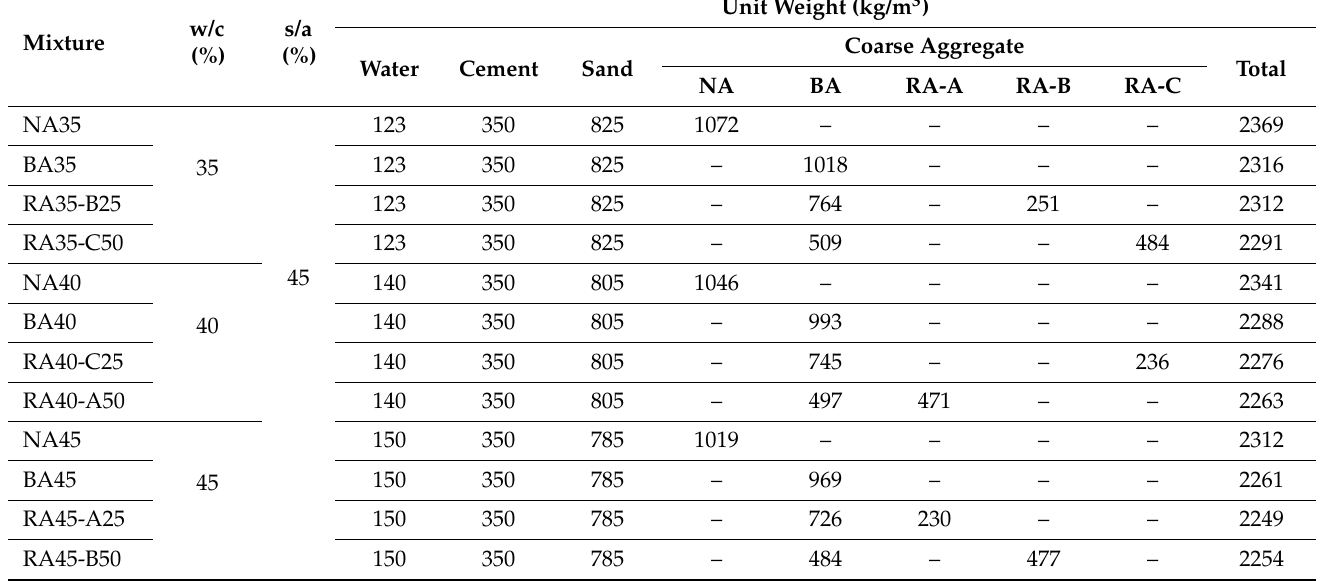
Table 2. Concrete mix